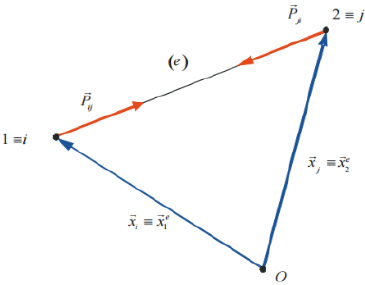
Figure 2: Linear element with local and global indexes [3]